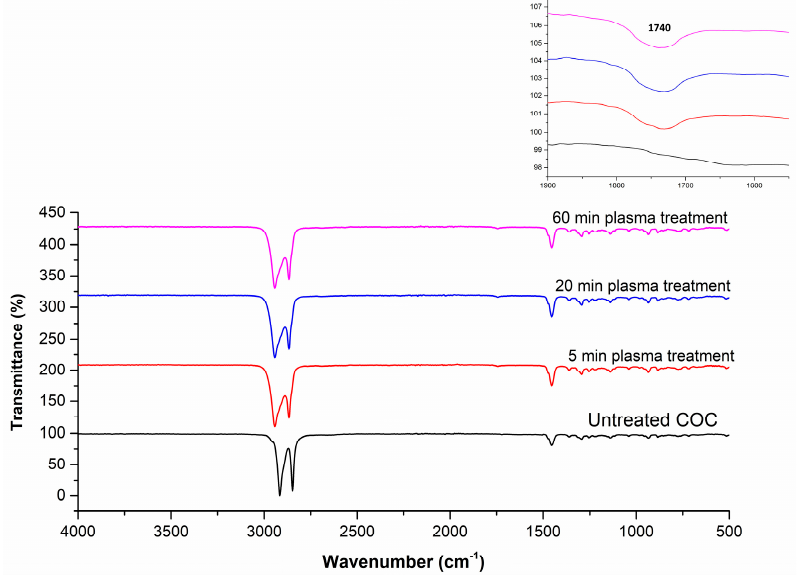
Figure 3. FTIR spectra for plasma − treated COC at different plasma exposure times. Table 1. Surface roughness of plasma treated COC at different plasma exposure times. Plasma Exposure Time (min)